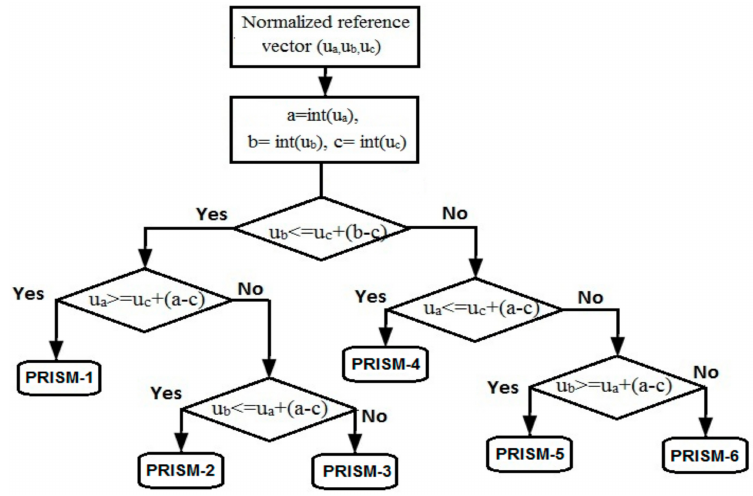
Figure 8. Flowchart for tracking of